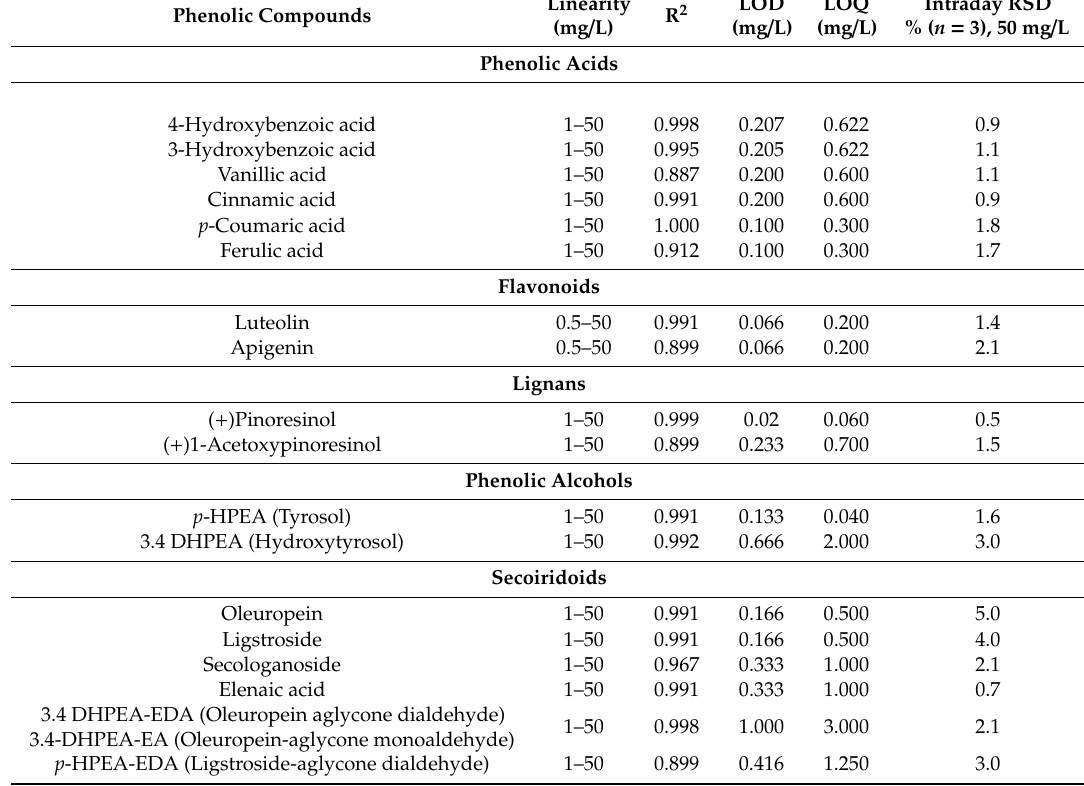
Table 1. Validation parameters for phenolics analysis by UPLC-HRMS-Orbitrap.